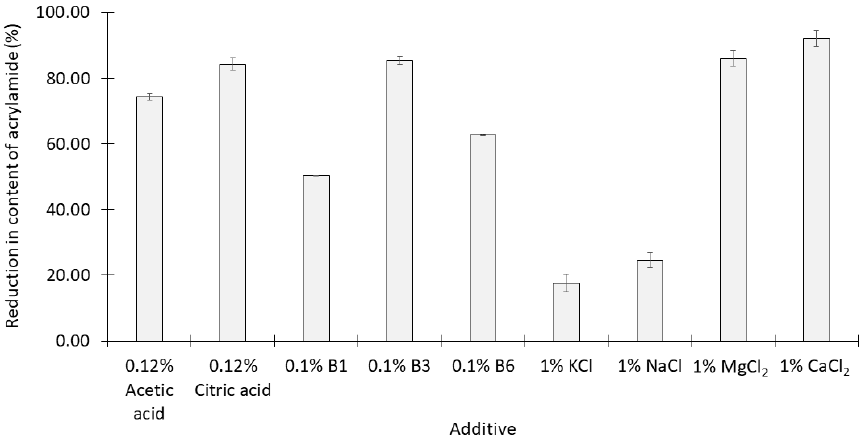
Figure 1. Reduction in the content of acrylamide (mean ± SD, n = 3) of syrup produced by single acids, vitamins, and salts added to thick simulated cane juice prior to heating at 120 °C for 30 min. Thus, citric acid, vitamin B3, and CaCl 2 were selected for the next step of the study, which was intended to investigate the effects of adding combinations of these three com- pounds on the concentrations of acrylamide and HMF